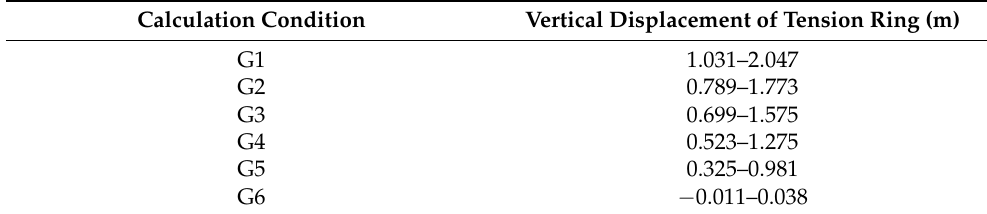
Table 17. Vertical displacement of tension ring.